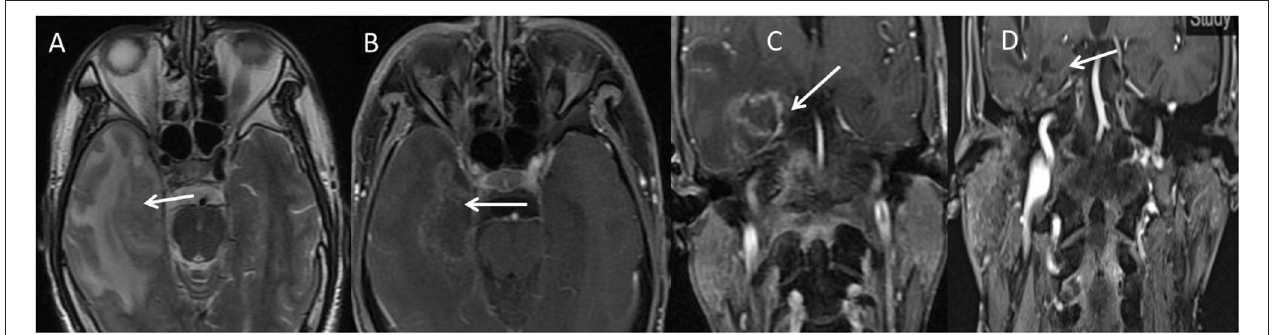
FIGURE 2 | Illustration of typical TLN necrosis (arrow) on MRI images. This was a 49-year-old male patient. When diagnosed with TLN, he had mild cognitive impairment (MMSE score 23). However, after treatment with nerve growth factor and pulsed steroids, his cognitive function returned to normal (MMSE score 28), and the necrotic mass completely disappeared. (A) Necrotic mass (arrow) in the right temporal lobe surrounded by a large area of edema on axial T2-weighted MRI. (B) Necrotic mass (arrow) in the right temporal lobe on axial contrast-enhanced T1-weighted MRI with fat suppression. (C) Necrotic mass (arrow) in the right temporal lobe on coronal contrast-enhanced T1-weighted MRI with fat suppression. (D) After intervention with nerve growth factor and pulsed steroids, the necrotic mass in the right temporal lobe completely disappeared, as shown on coronal contrast-enhanced T1-weighted MRI with fat suppression, and his cognitive function recovered to a normal level (MMSE score